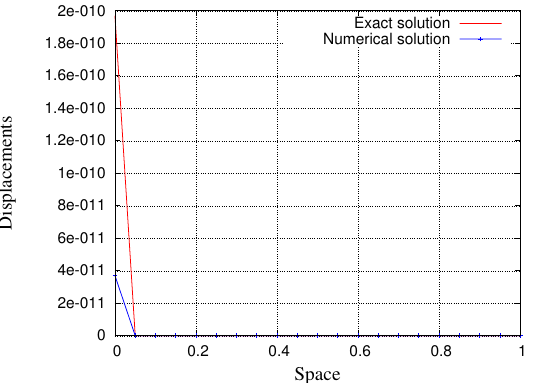
Figure 7. Comparison between an accurate enough approximation of the analytical solution and an approximated solution for displacements obtained by perturbed scheme (3.6) for the column problem at time T = 0 . 001 and N = M =